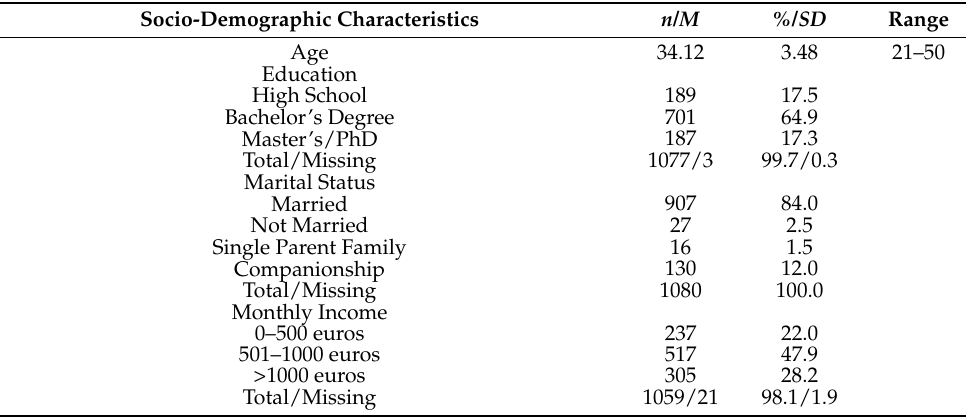
Table 1. Socio-demographic, Perinatal, Mental Health and Breastfeeding